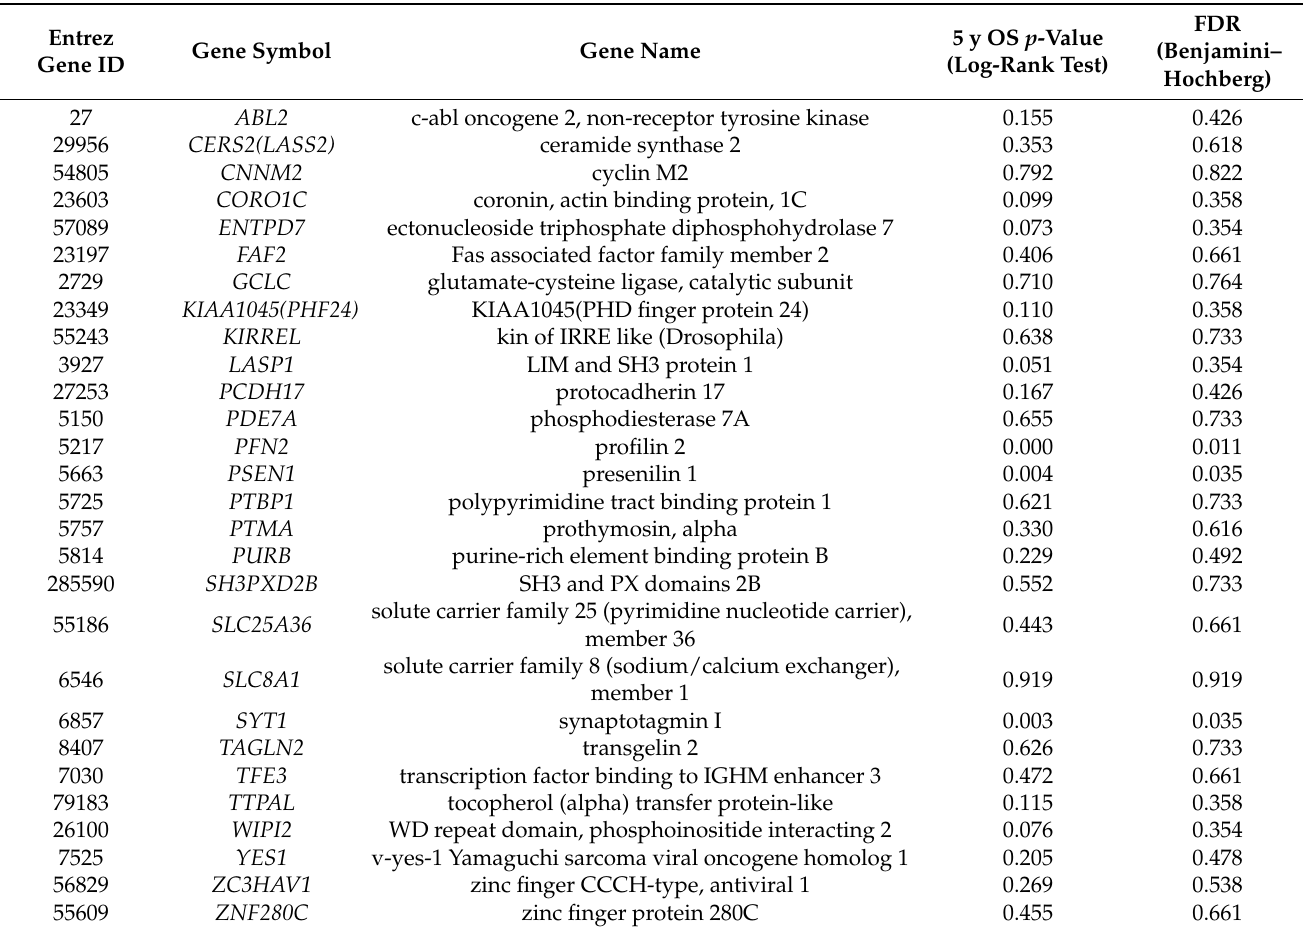
Table 1. Twenty-eight candidate target genes regulated by both miR-133a-3p / miR-133b and miR-1- 3p / miR-206